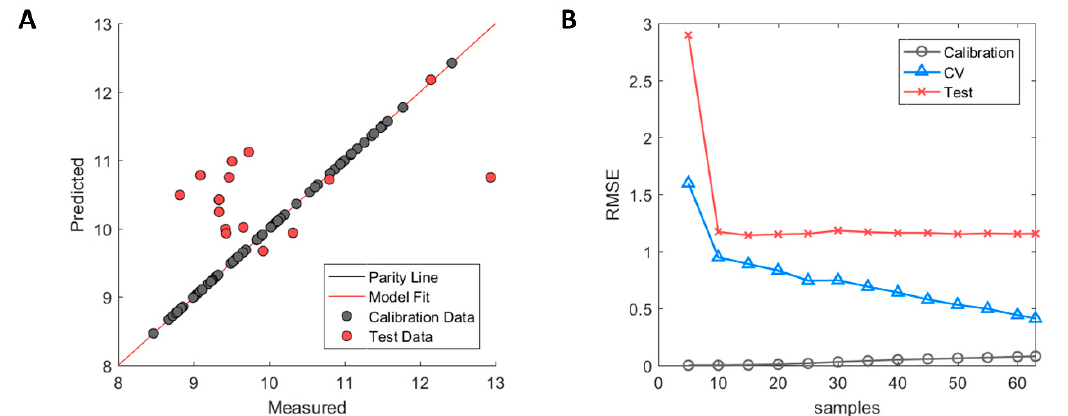
Figure 2. Performance of Hom3D based model after genetic algorithm with partial least square (GA-PLS) selection. ( A ) Measured versus predicted values of calibration (grey) and test set (red) samples. ( B ) Model learning curve for Hom3D based model showing the change of RMSE for calibration (grey circle), cross-validation (blue triangle) and test set (red cross). Optimised ϵ -SVM model parameters from original calibration model were used.